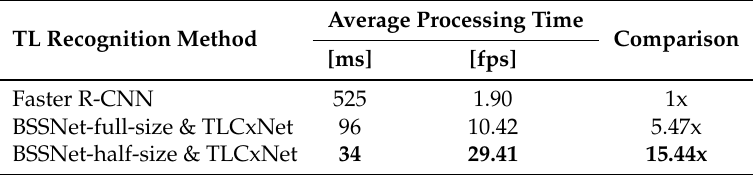
Table 8. Computational complexity according to TL